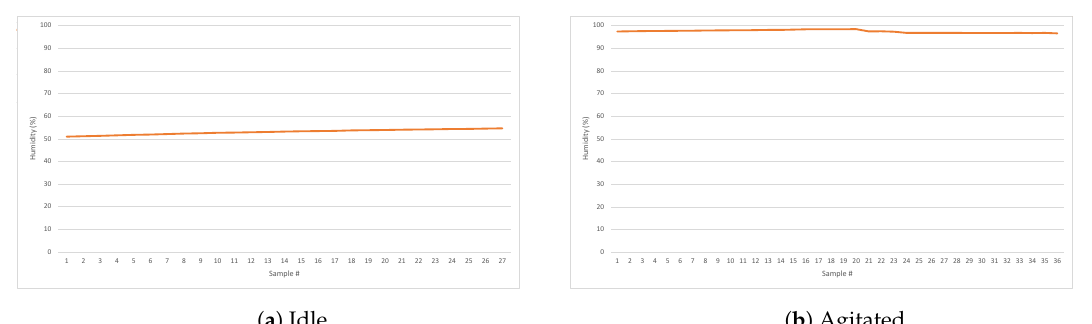
Figure 9. Acceleration data of an idle vs. agitated patient.